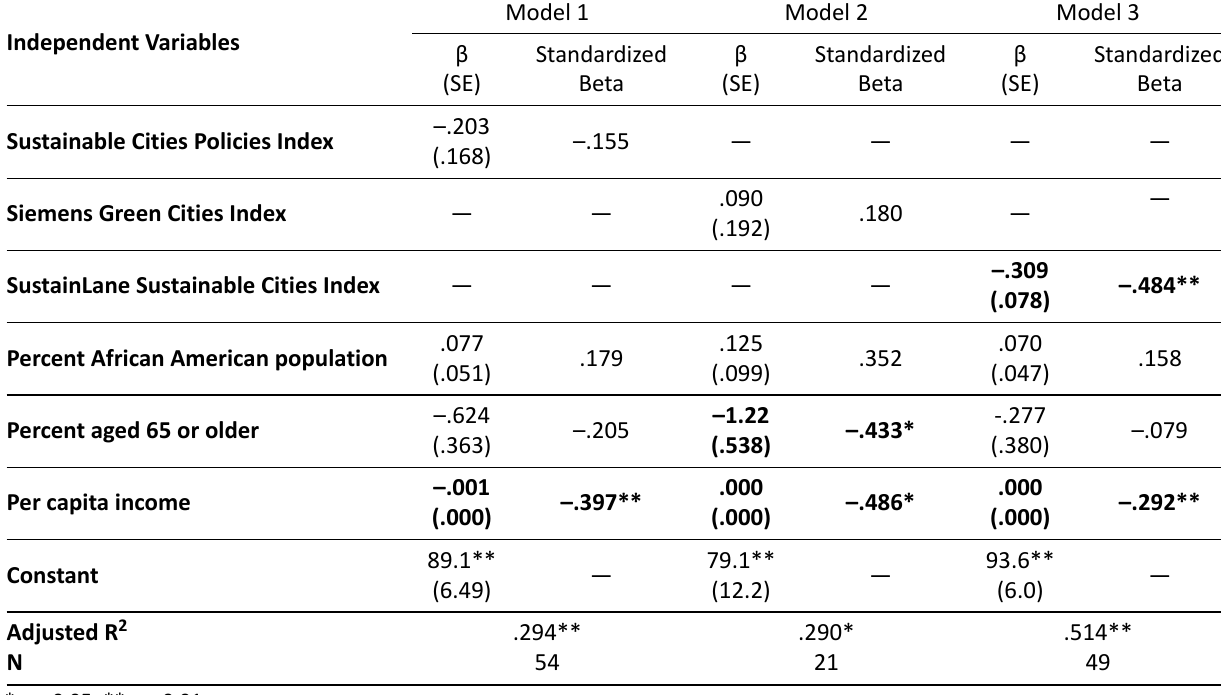
Table 4. OLS regression results showing the effects of sustainability on obesity levels (Fattest Cities in America Index) in large U.S.